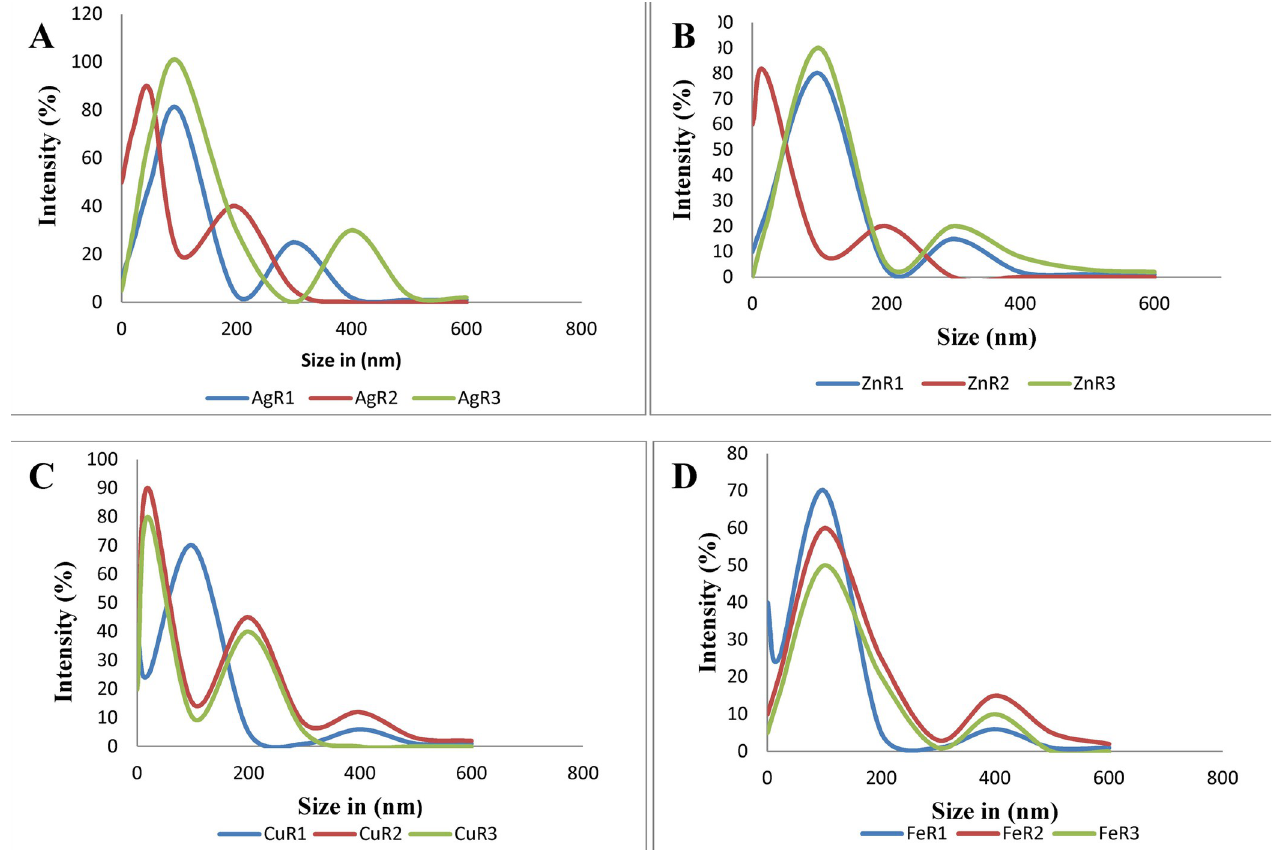
Fig 2. DLS results of (A) AgNPs synthesized by using 10 mL of 2 mM AgNO 3 solution with 10, 20 and, 30 mL of R . communis extract (B) ZnO NPs synthesized by using 10 mL of 2 mM ZnSO 4 solution with 10, 20 and, 30 mL of R . communis extract (C) CuO NPs synthesized by using 10 mL of 2 mM CuSO 4 solution with 10, 20 and, 30 mL of R . communis extract (D) FeO NPs synthesized by using 10 mL of 2 mM FeCl 3 solution with 10, 20 and, 30 mL of R . communis